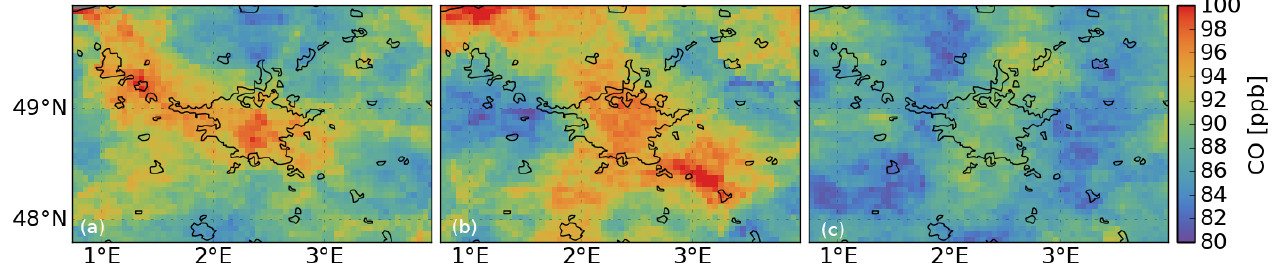
Figure 7. SCIAMACHY CO column mixing ratio averaged from January 2003 to April 2012 under clear-sky (a) , low-cloud (b) and medium– high-cloud (c) atmospheric conditions above Paris. The spatial sampling of the plot is δ = 0 . 05 ◦ in latitude and longitude and the data are averaged with radius r = 40km. The urban area contours are based on MODIS measurements (Schneider et al., 2009).